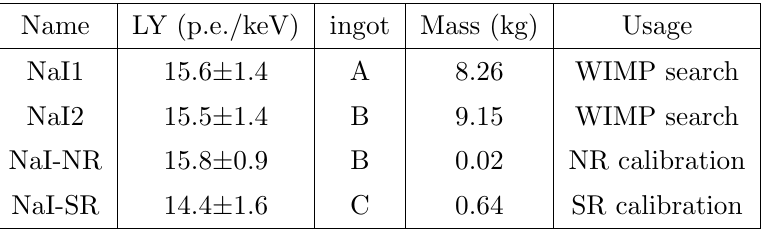
each recoil type in (cid:12)gure 4. As one can see in this plot, our data are dominantly